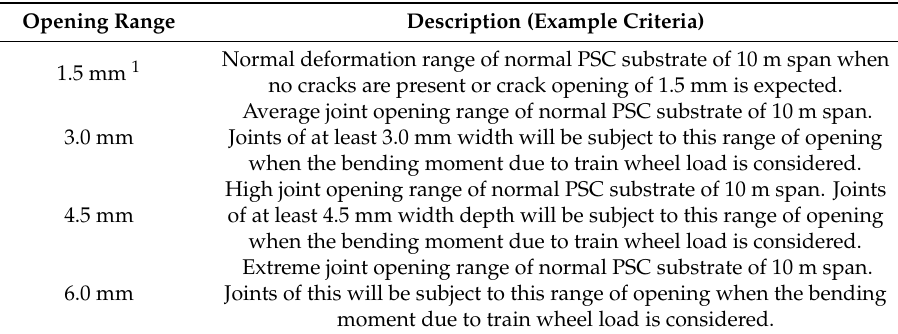
Table 7. Opening range for testing demonstration.